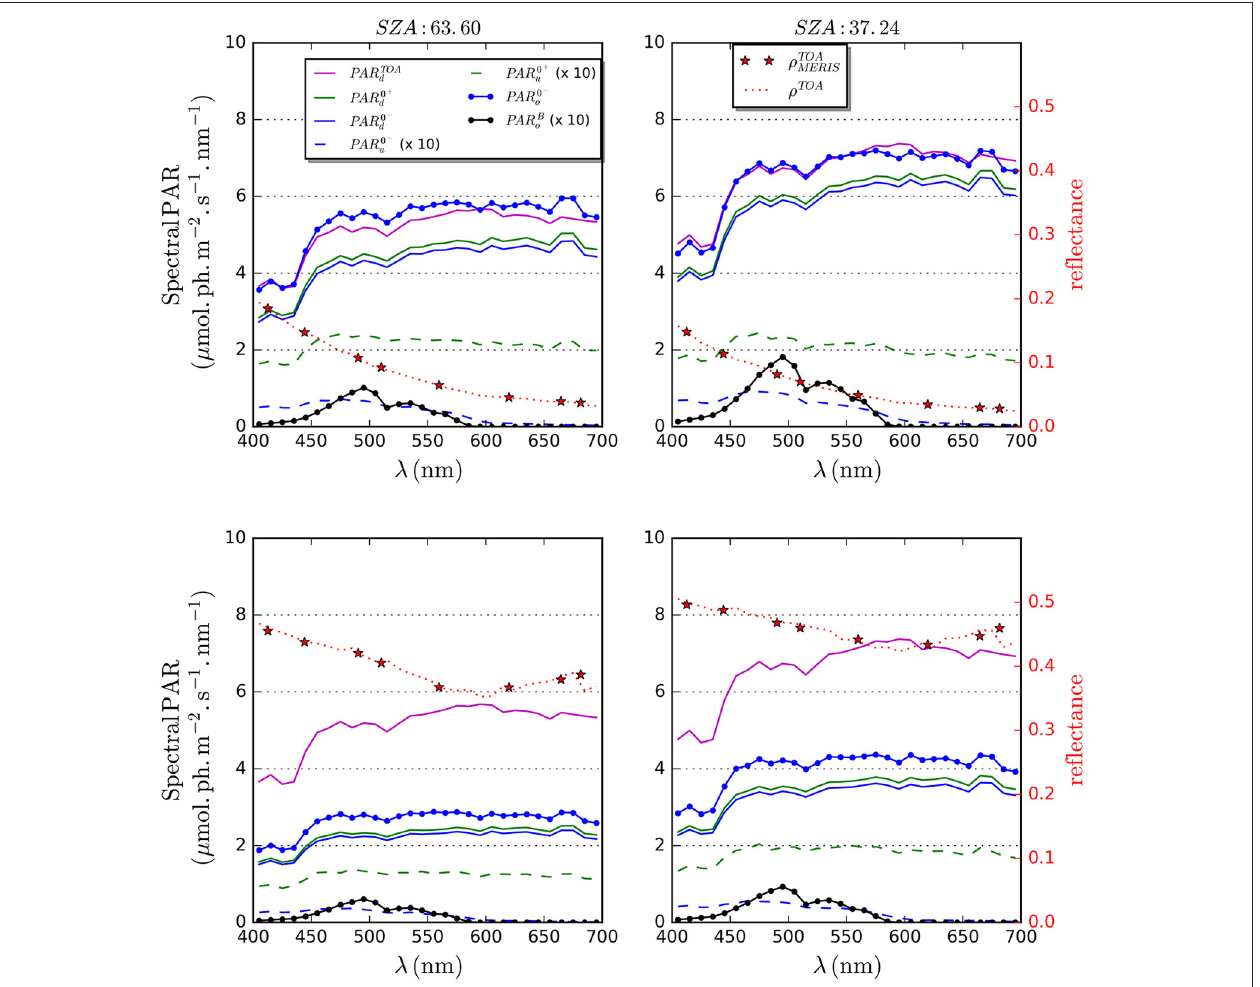
FIGURE 9 | Examples of outputs of the SMART-G RTC code for 4 situations. On the left axis is reported the “spectral PAR” in units of light quanta per unit time, unit area and unit wavelength for planar and spherical upwelling (“u”) or downwelling irradiances (“d”) at several levels in the ocean-atmosphere coupled system: at TOA, just above (0 + ) or below (0 − ) the surface, or at the black bottom (superscript B) of the ocean located here at a depth of 50m. On the right axis is plotted the TOA spectral reflectance at the same resolution, and at the center of MERIS wavebands. The top two graphs are for a clear-sky situation for two Sun zenith angles (SZA) and the bottom two graphs a liquid water cloud, located between 2 and 4km with droplets of effective radius = 11mm whose of optical thickness 10 is added. The clear atmosphere model is the US62 standard atmosphere, with maritime polluted aerosols as described in the OPAC database with an AOT at 550nm equal to 0.1. The ozone column is 300 DU and the precipitable water quantity is 2 g/cm 2